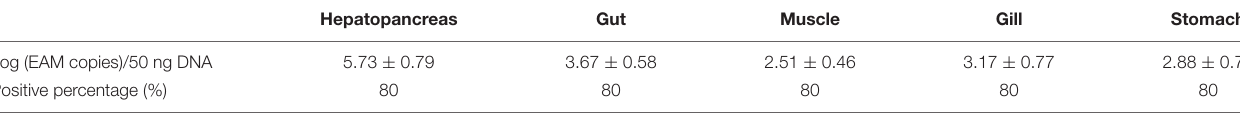
TABLE 3 | Tissue tropisms of EAM in P. sinensis.